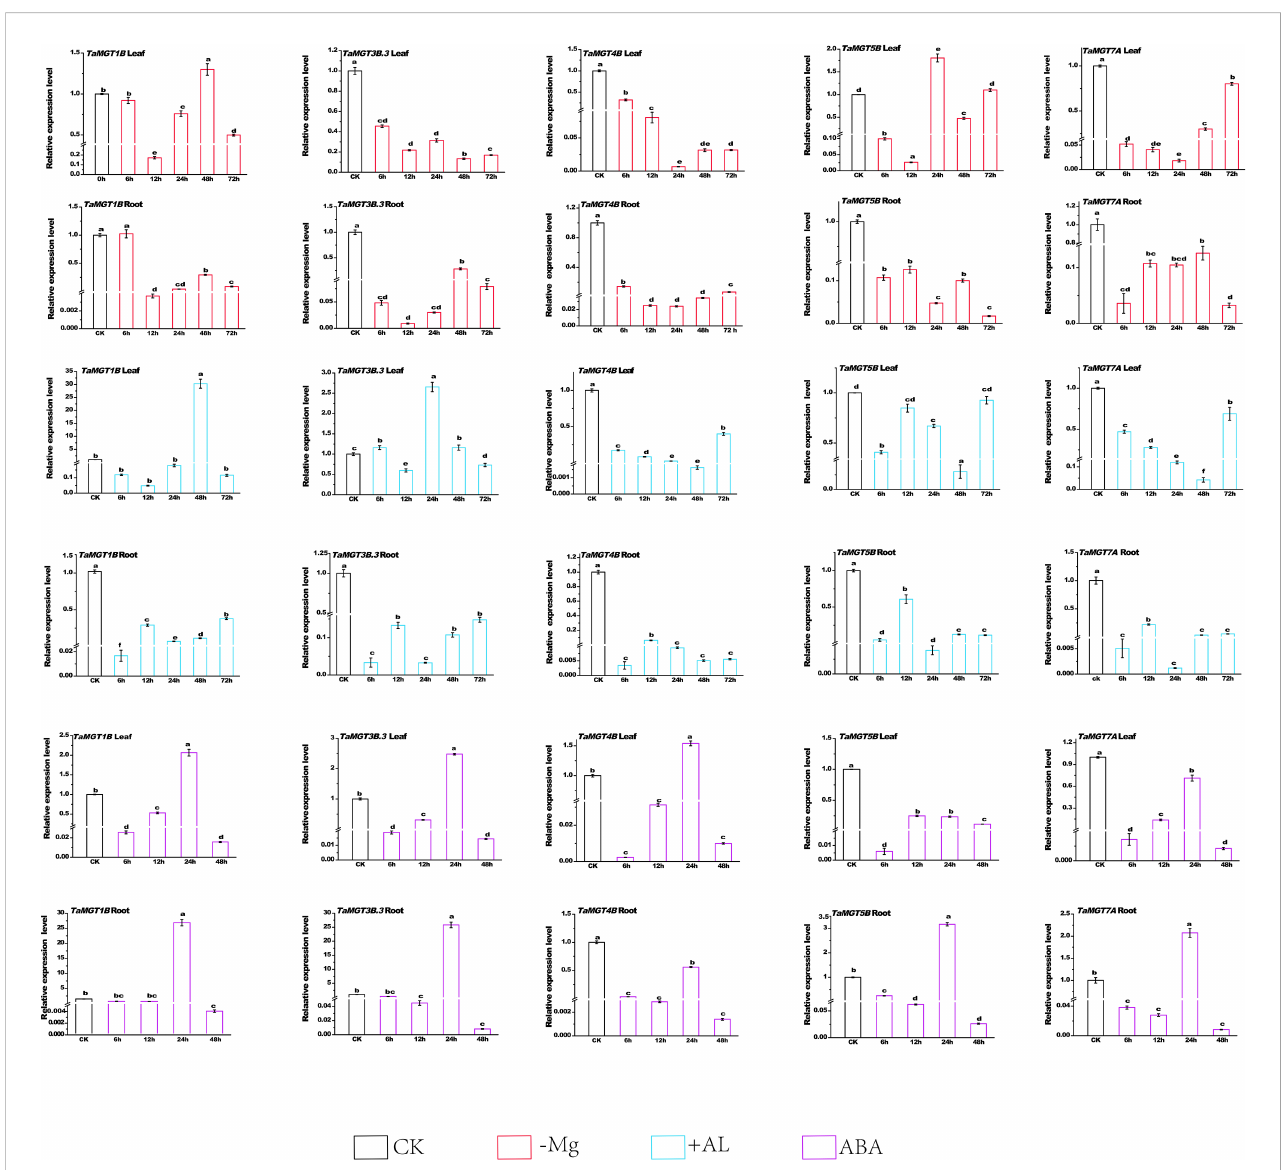
FIGURE 7 Expression patterns of fi ve TaMGT genes under three different treatments. Three groups of treatments included 60uM aluminum chloride, 100 mmol/L ABA treatment, and magnesium de fi ciency treatment. The Y-axis represents the relative expression level, and the X-axis represents the time point of treatment. Signi fi cant differences at P<0.05 are indicated by letters. The expression levels of TaMGT genes were mapped using Origin